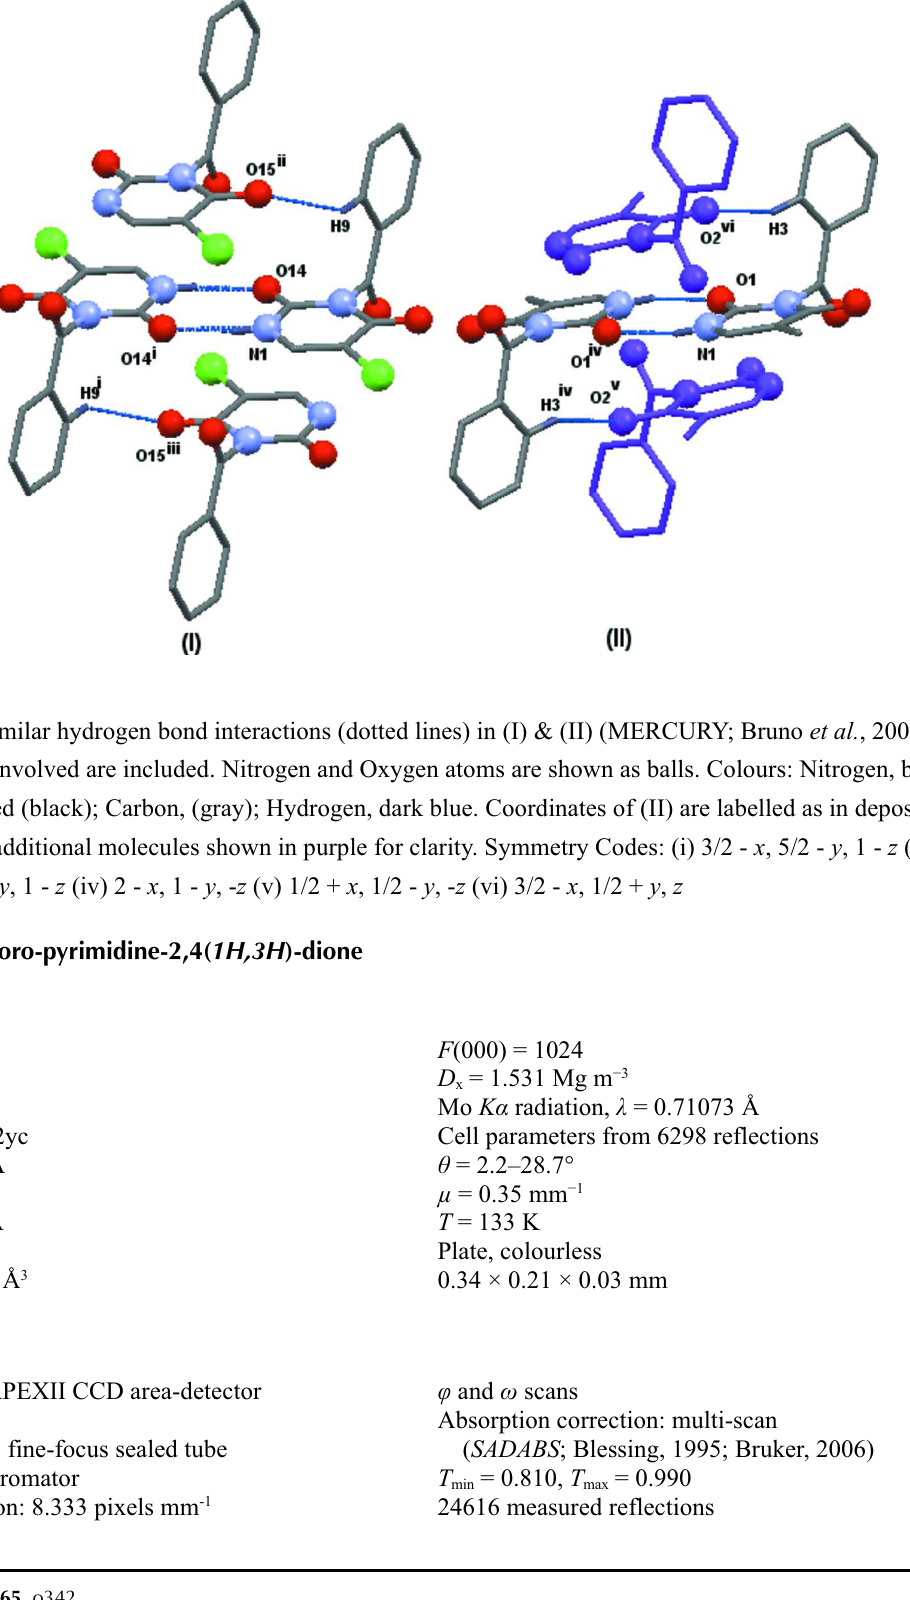
Molecular structure of the title compound. Displacement ellipsoids are shown at the 30% probability level.